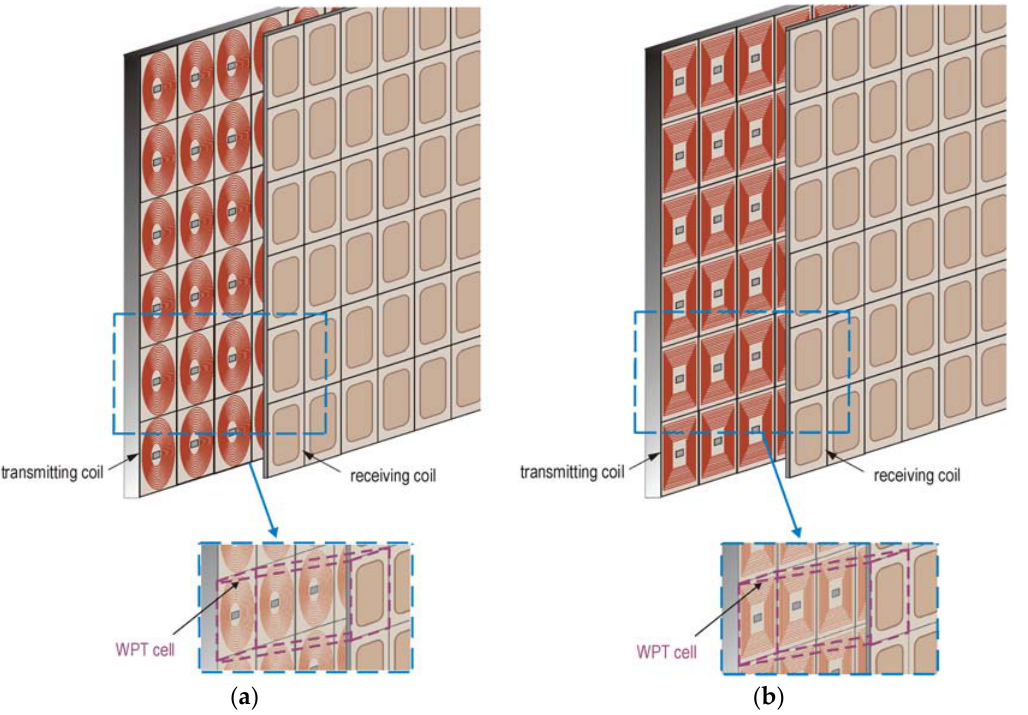
surface are connected to loads ( Z l ).